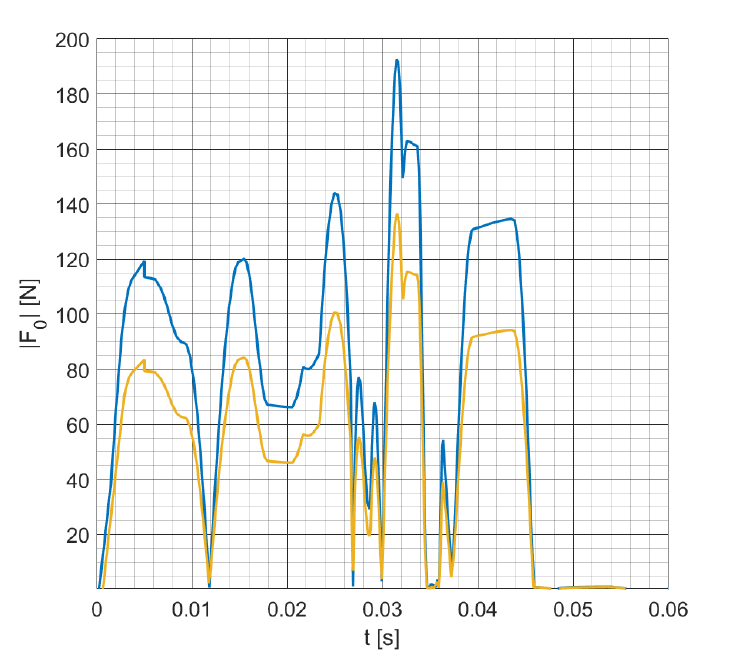
Figure 9. Magnitude of the base reaction F 0 : comparison between the initial design (blue) and the reduced-mass design